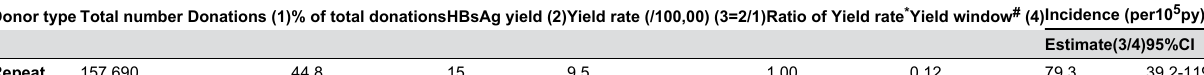
Table 5. Incidence estimates based on verified HBsAg yield donations to Anhui from 2009 to 2011.